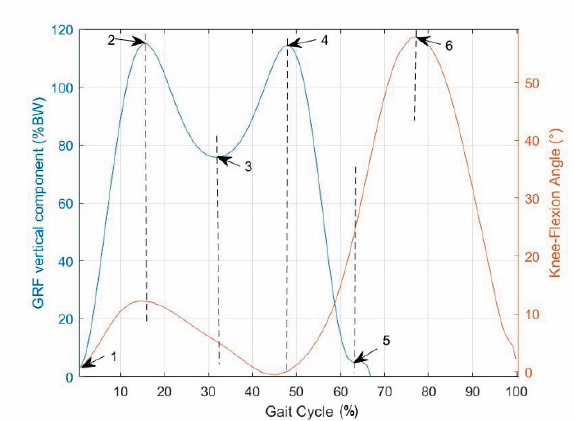
Figure 6 . Identification of the gait-cycle events: superposition of the two fitting curves (i.e., knee- flexion angle and GRF vertical component as functions of the gait-cycle percentage).